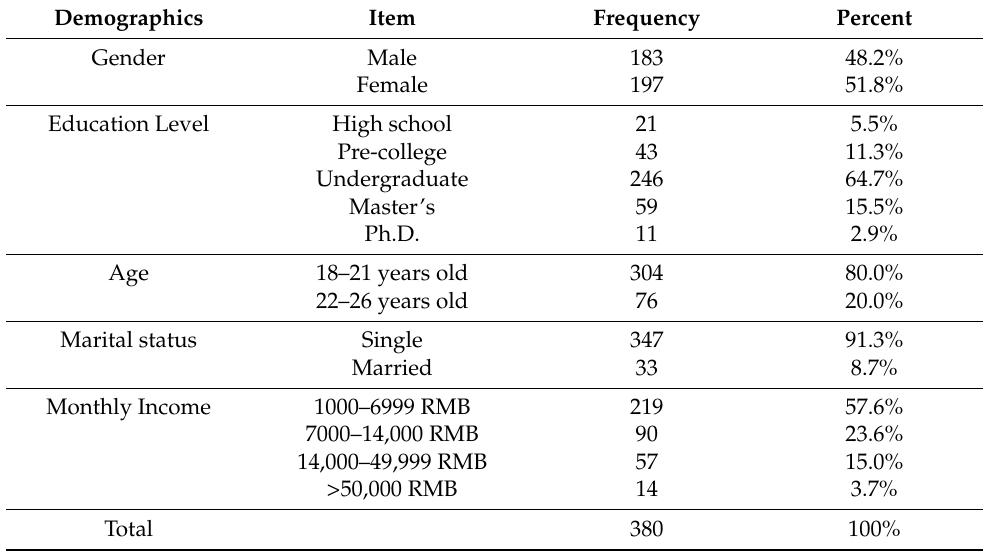
Table 1. Key demographic characteristics of the survey participants.